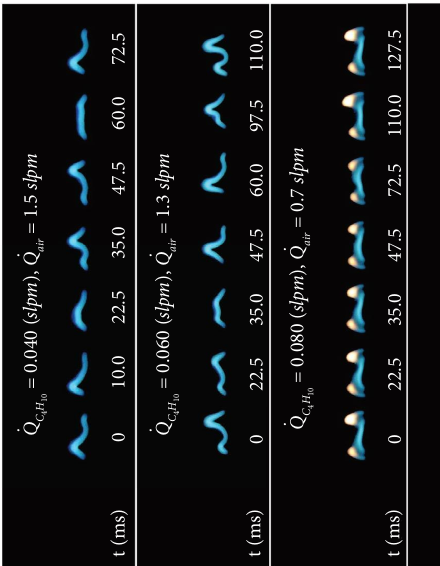
Figure 7: Examples of oscillatory fames at three operating conditions.